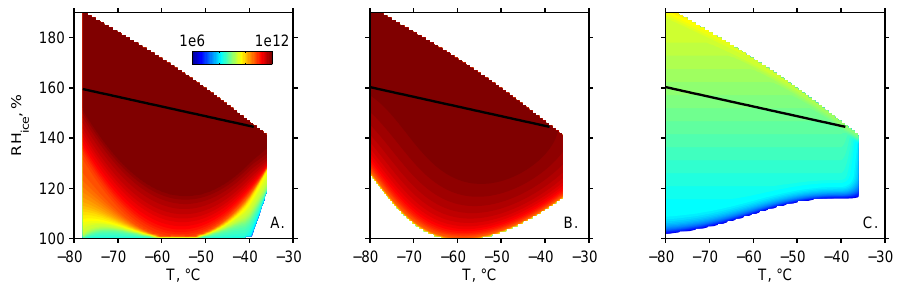
Figure 4. Spatial plot of isolines for constant n s derived from (a) interpolating AIDA data, (b) applying the third-degree-polynomial fit function to interpolated AIDA data, and (c) a previously published parameterization (Phillips et al., 2013) for hematite particles. The color scale displays log-scaled n s values per square meter, applicable to all panels. The solid black lines indicate the homogeneous freezing threshold line (i.e., Koop